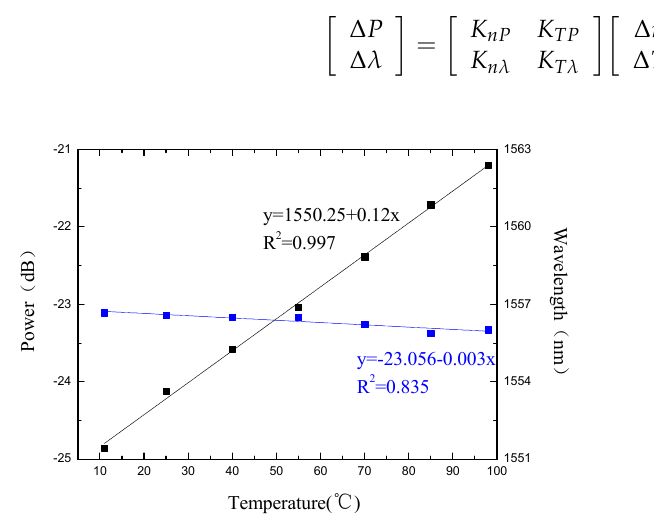
Figure 12. The temperature response of the Michelson interferometer. In Equation (12), ∆ n and ∆ T are the refractive index and temperature changes, re- spectively. K nP and K n λ are the intensity and wavelength response sensitivities when the refractive index changes. K TP and K T λ are the intensity and wavelength response